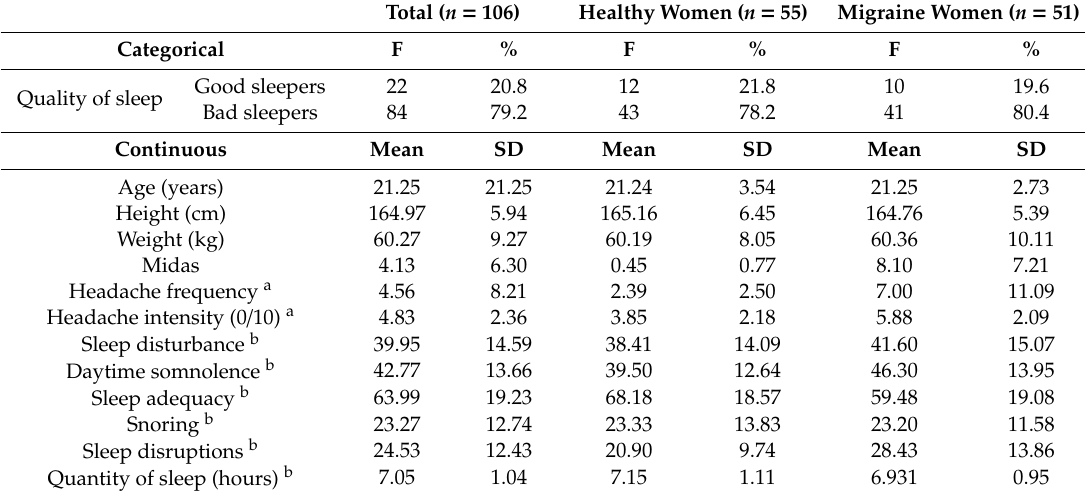
Table 1. Description of the study participants.